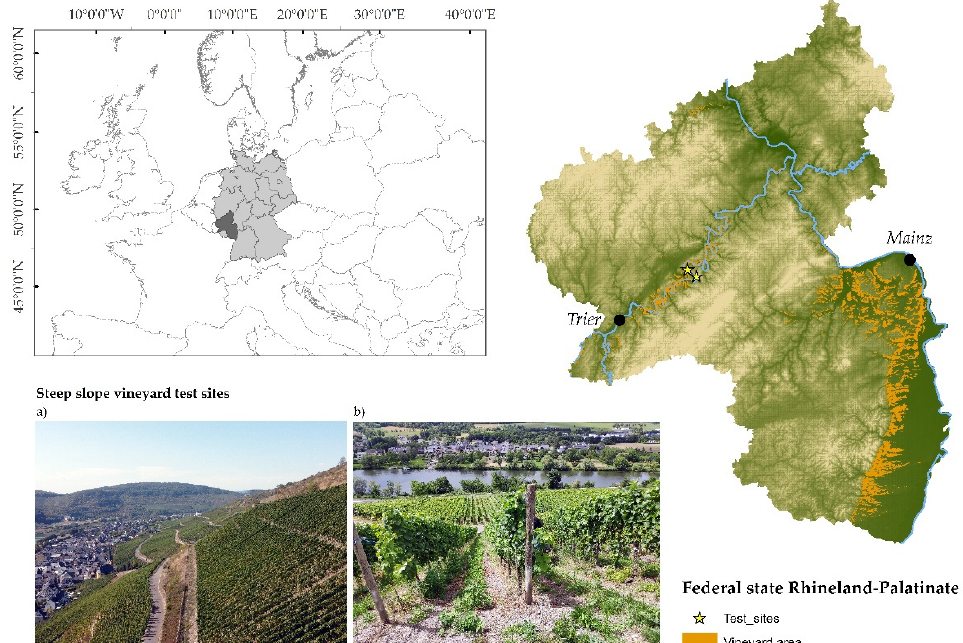
Figure 2. Study sites ( a ) Zeltingen and ( b ) Kues in the Moselle area.